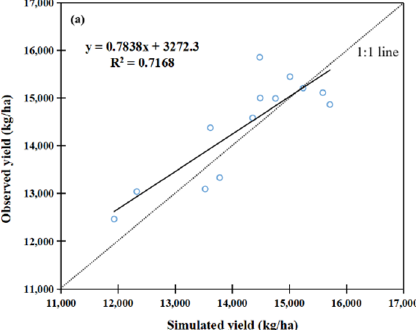
Figure 3. Calibration and validation of the AquaCrop model with yield (2014–2017).